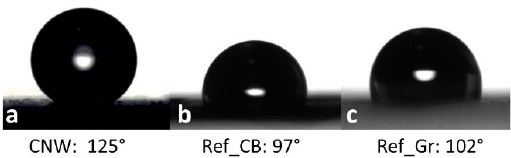
Figure 6. Contact angle measurements of CNW ( a ) and reference materials: carbon black ( b ), respectively, and graphenes ( c ) deposited on carbon paper.